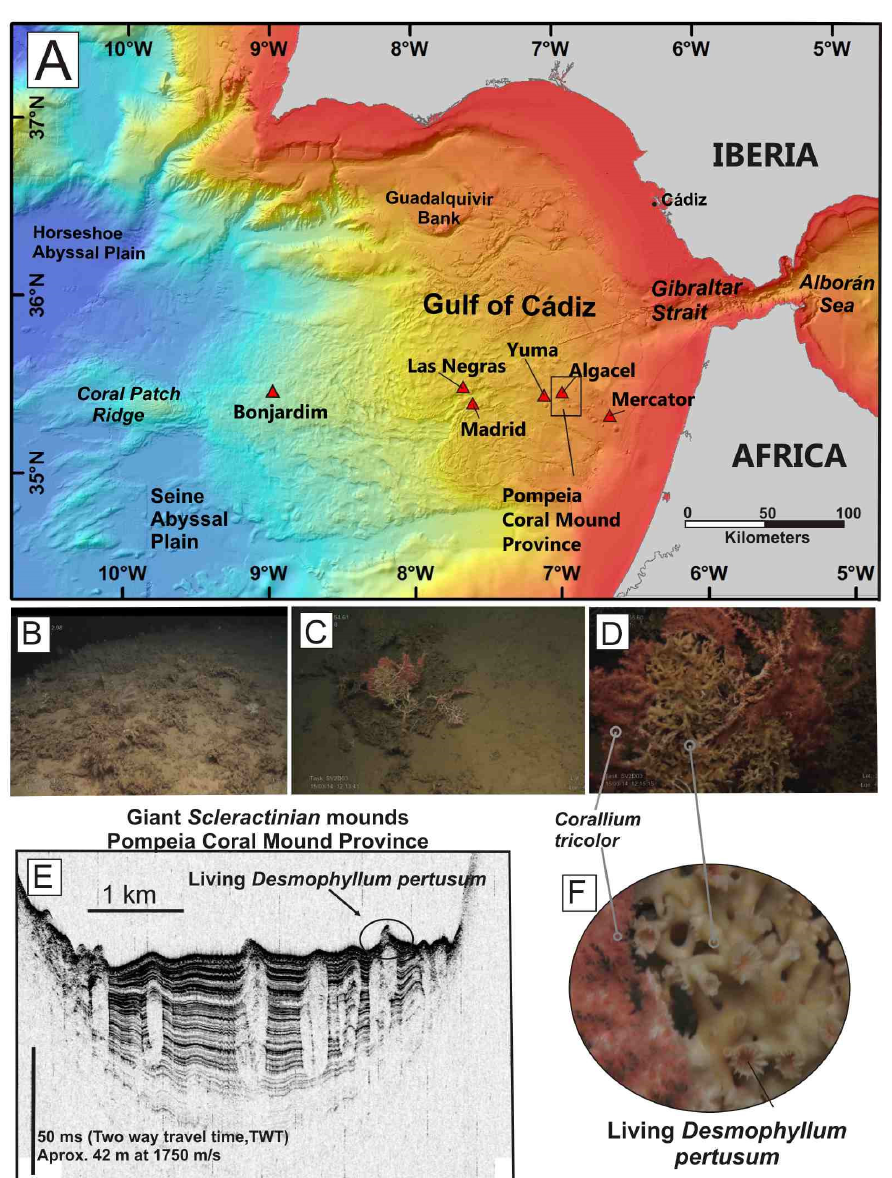
Figure 4. ( A ) Location of mud volcanoes explored in the present study in the Gulf of Cádiz along 35.5° N and the Pompeia Coral Mound Province. ( B ) Dead scleractinian skeletons at the top of the mounds. ( C , D , F ) Stony octocorals ( Corallium tricolor ) overlying live and dead colonies